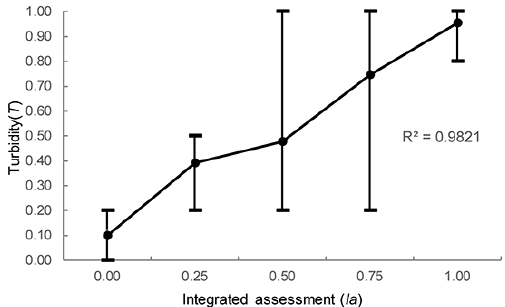
Figure 7. The correlation between I a and S .